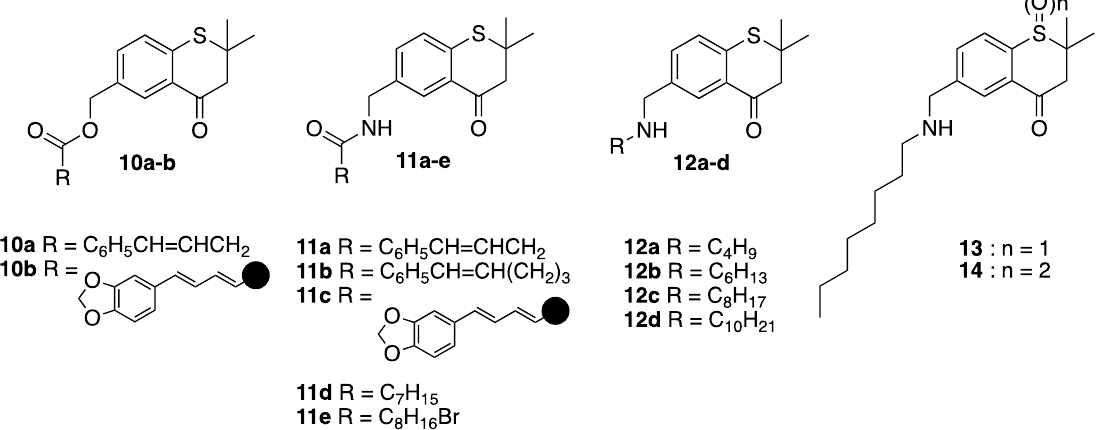
Figure 3. Synthetic targets based on lead compounds 1 – 3 .